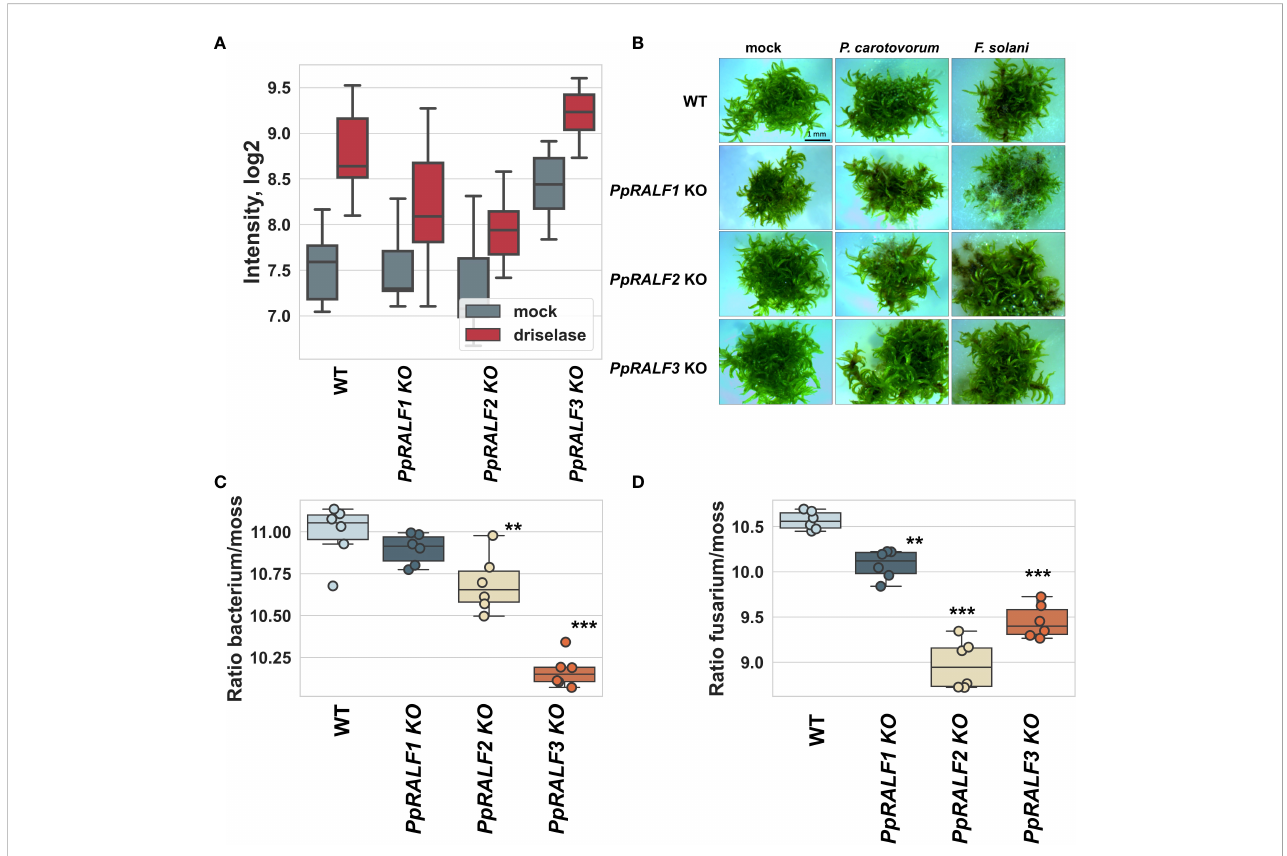
FIGURE 4 (A) Effect of PpRALF gene knockouts on ROS production in wild-type and knockout lines treated with 0.0025% driselase; (B) Symptom development at 7 dpi in wild-type, PpRALF1 , PpRALF2 and PpRALF3 KO moss plants. Scale bar: 1 mm; (C) Ratios of P. carotovorum DNA levels to P. patens genomic DNA that were estimated by qPCR analysis. (D) Ratios of F. solani DNA levels to P. patens genomic DNA that were estimated by qPCR analysis. The results of six independent experiments are shown. Analysis of variance and Tukey ’ s HSD post hoc tests were performed for qPCR data. ** P < 0.01, *** P <